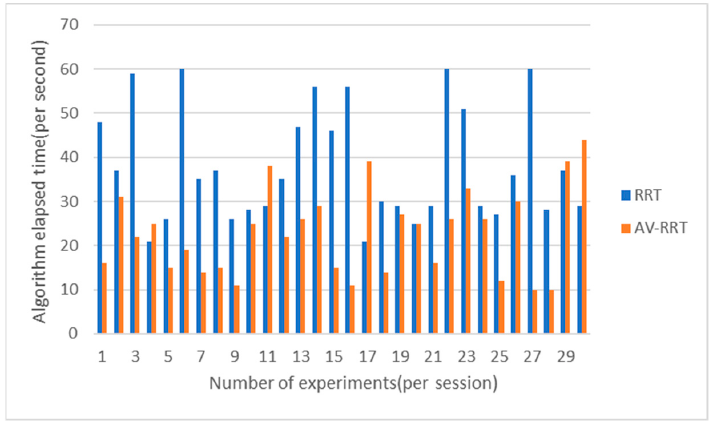
Figure 22. Comparison of consumption of time in the scene with sparse obstacles.